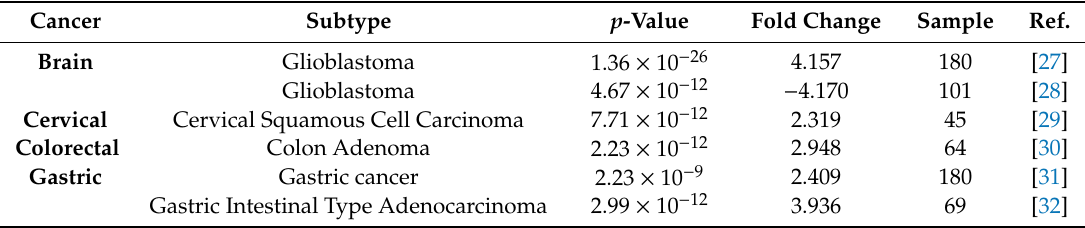
Table 1. Expression of CHEK1 in solid tumors (rank of 1%).